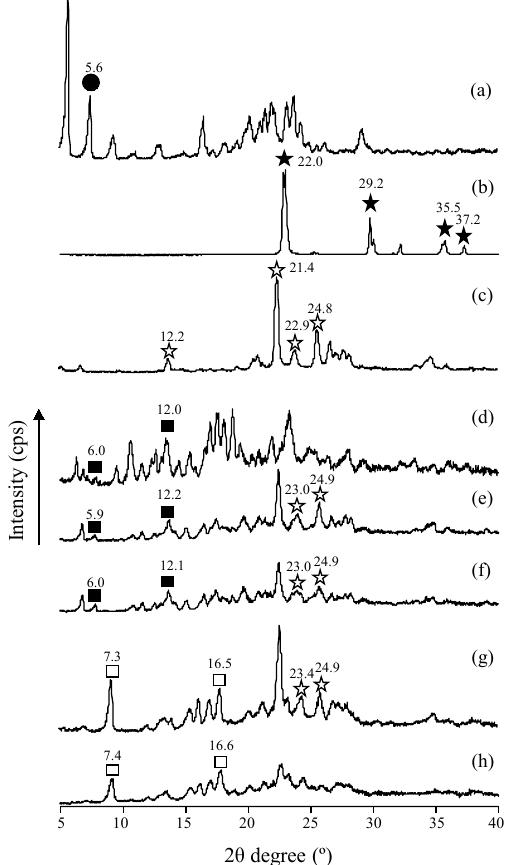
Figure 2. PXRD patterns of AU (ASCP/UR = 1/12)/ γ CD systems. ( a ) ASCP intact, ( b ) UR intact, ( c ) EVP AU (ASCP/UR = 1/12), ( d ) γ CD intact, ( e ) PM (AU (ASC/UR = 1/12)/ γ CD = 1/1), ( f ) PM (AU (ASC/UR = 1/12)/ γ CD = 1/2), ( g ) GM (AU (ASC/UR = 1/12)/ γ CD = 1/1), ( h ) GM (AU (ASC/UR = 1/12)/ γ CD = 1/2) ● : ASCP, ★ : UR (tetragonal form), ☆ : UR (hexagonal form), ■ : γ CD, □ : γ CD (tetragonal-columnar form).